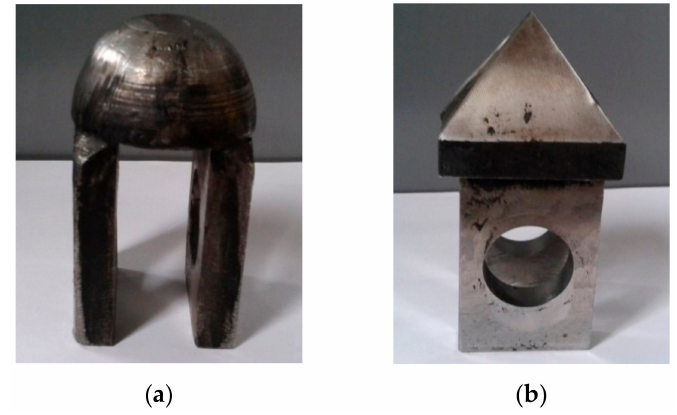
Figure 5. Used impactor types: ( a ) semi-spherical impactor, ( b ) pyramidal